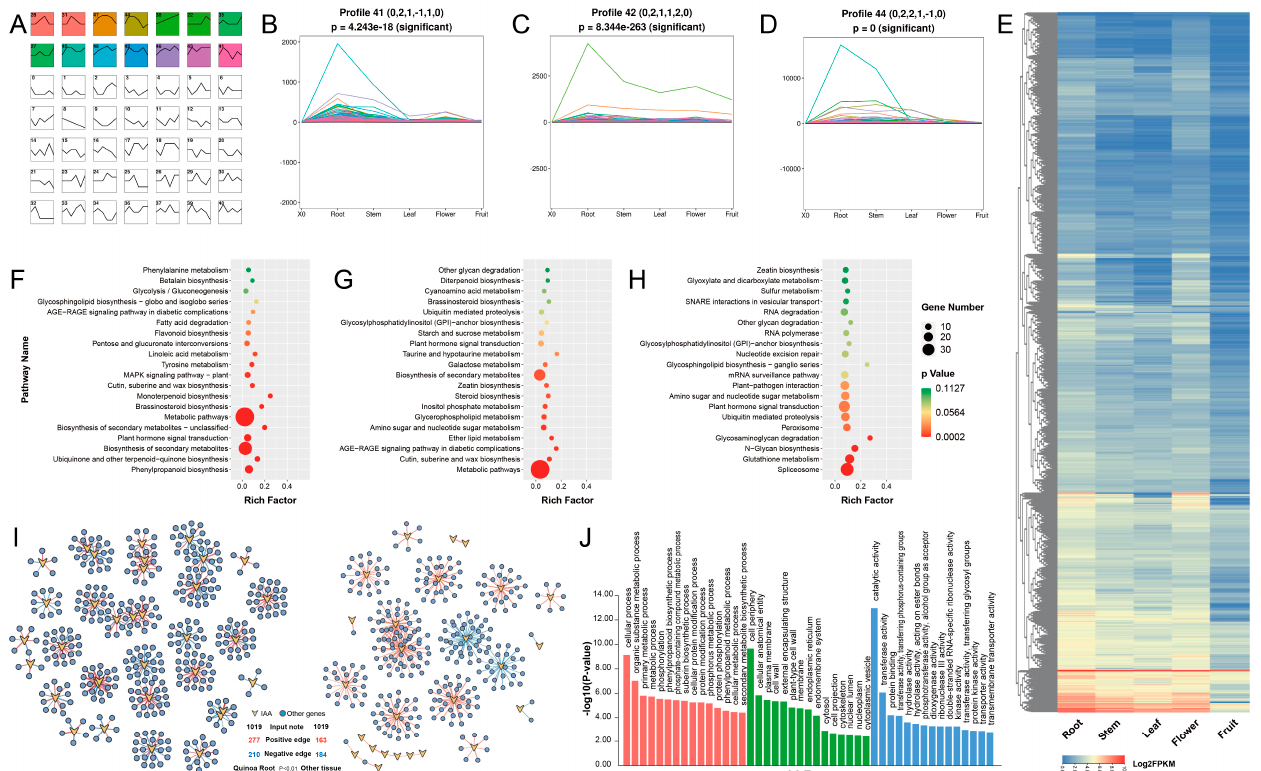
Figure 4. Search for highly expressed genes in quinoa roots, construction of networks associated and functional prediction of CqIAAs potential target genes. ( A ). The 49 expression trend maps based on the RNA-seq data of quinoa roots, the first 14 of which were labeled color profiles were statistically significant; ( B – D ). Display of expression trends of three highly expressed gene profiles (profile 41,42 and 44) in roots; detailed data are recorded in the Table S8; ( E ). Heat maps showing in five tissues further confirmed that the transcription level of these genes in roots was significantly higher than that in other tissues; ( F–H ). KEGG pathway enrichment for three highly expressed gene profiles (profile 41, 42, and 44) in roots; Detailed data are recorded in the Table S8; ( I ). Correlation network between genes and CqIAAs formation in 3 profiles. The yellow diamonds represents CqIAAs , and blue circle represents the genes in 3 profiles. The red line represents positive correlation; the blue line represents negative correlation. correlation network is obtained by p < 0.01 as threshold screening. Networks on the left and right are constructed using the RNA-seq data root and other organizations, respectively; detailed data are recorded in the Table S9; ( J ). GO enrichment of CqIAAs ’ target genes in correlation networks. red, green, and blue column distributions represent three terms. of biological processes, cellular components, and molecular functions. The top 15 entries in each term were chosen for presentation. Detailed data are recorded in the Table S10 .